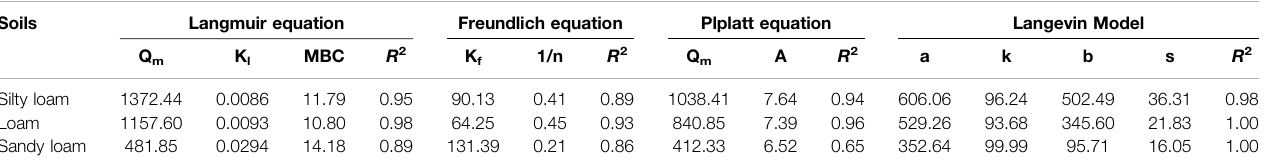
TABLE 8 | Related parameters in the adsorption thermodynamic fi tting equation. Soils Langmuir equation Freundlich equation Plplatt